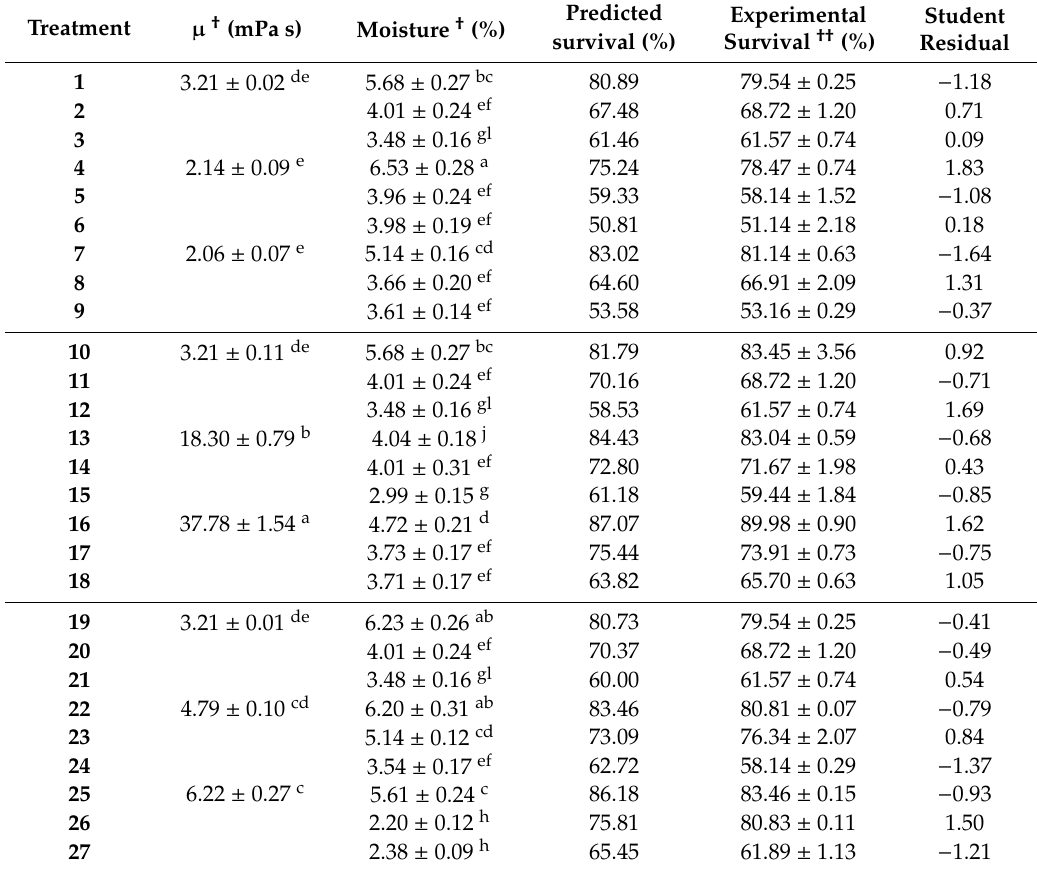
Table 2. Viscosity of encapsulating solution ( µ ), moisture content of powder, and survival of L. rhamnosus after spray drying, and response given by the model derived from the experimental